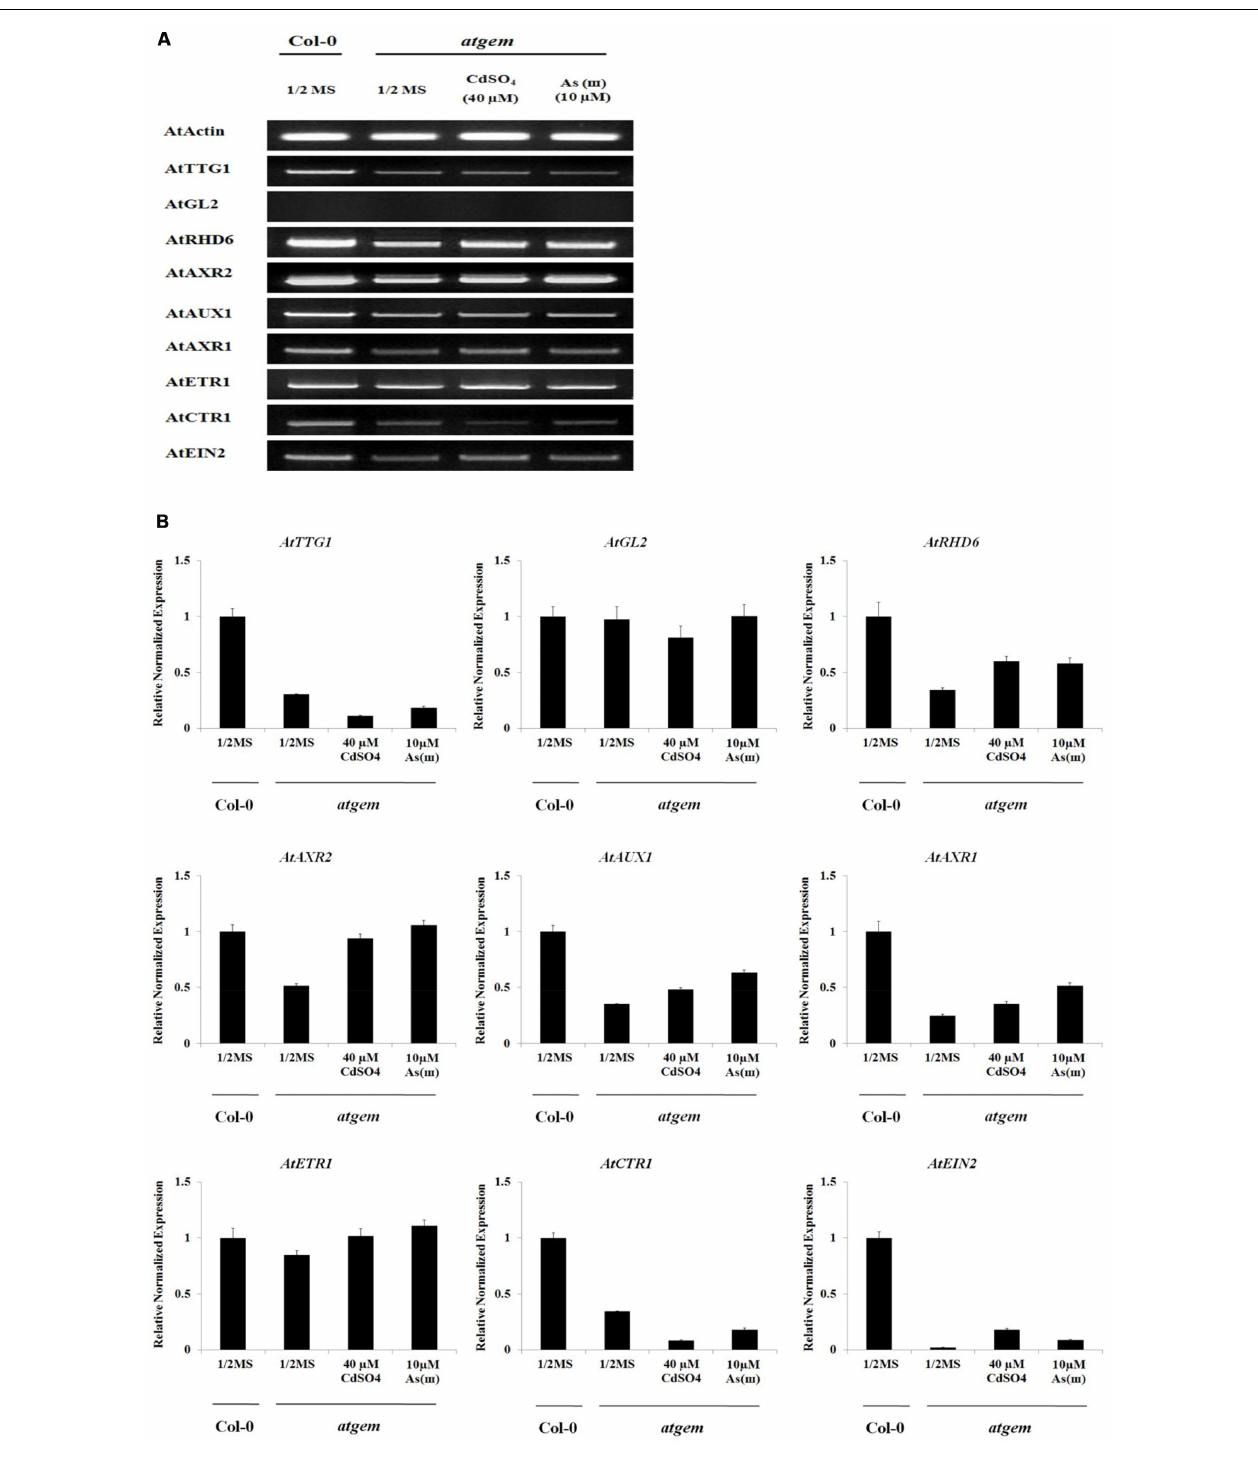
FIGURE 8 | Effect of Cd and As(III) on expressions of genes engaged in the differentiation (fate determination) and elongation of root hairs in gem Arabidopsis . (A) Semi-quantitative RT-PCR results showing relative transcript levels of various genes involved in the differentiation ( TTG1 and GL2 ), initiation ( RHD6 and ACXR2 ) and elongation ( AUX1 , AXR1 , ETR1, CTR1, and EIN2 ) of root hairs in Col-0 and gem Arabidopsis . RT-PCR was performed using total RNA isolated from 1-week old plants which were germinated and grown on 1/2 MS agar media treated with no metal, 40 µ M CdSO 4 and 10 µ M As(III). The gel photography represents three experimental replicates. (B) Quantitative real-time PCR results of various genes involved in root hair differentiation and elongation shown in (A) . Transcript levels were normalized to the transcript level of Actin .